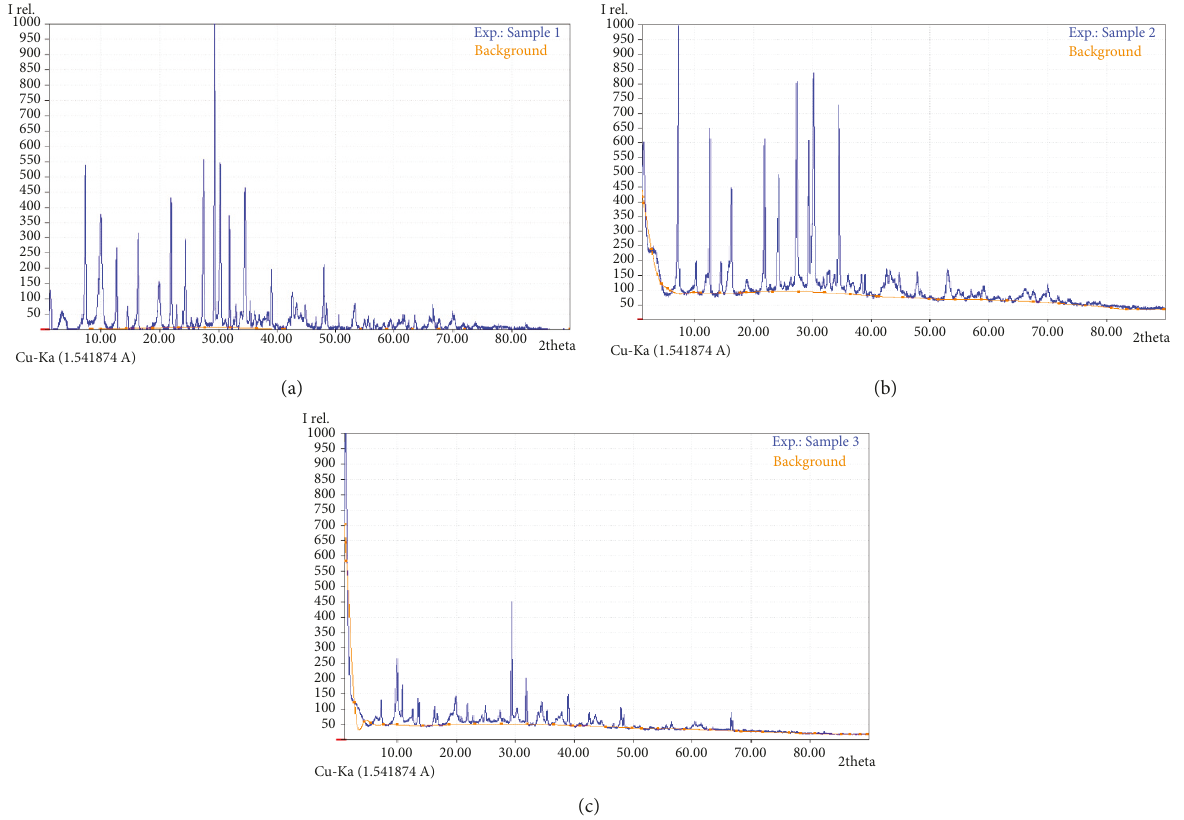
Figure 9: XRD spectrum of (a) ZNPs, (b) activated carbon, and (c) zinc oxide-activated carbon nanocomposite.